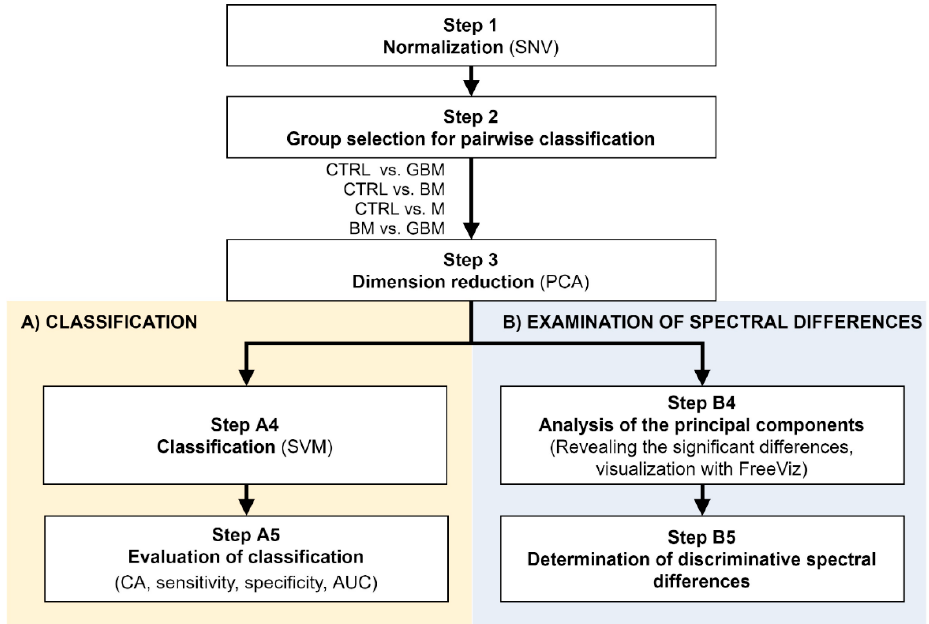
Figure 2. Workflow of Raman spectroscopic data processing. The figure shows the analysis step by step. After Step 3, the workflow separates (parts A and B ) according to the purpose of the analysis. (Abbreviations: AUC, area under the curve; CA, classification accuracy; SNV, standard normal variate; SVM, support-vector machine; PCA, principal component analysis). After averaging the spectra, row normalization was performed using the SNV method (Step 1) (Figure 3).